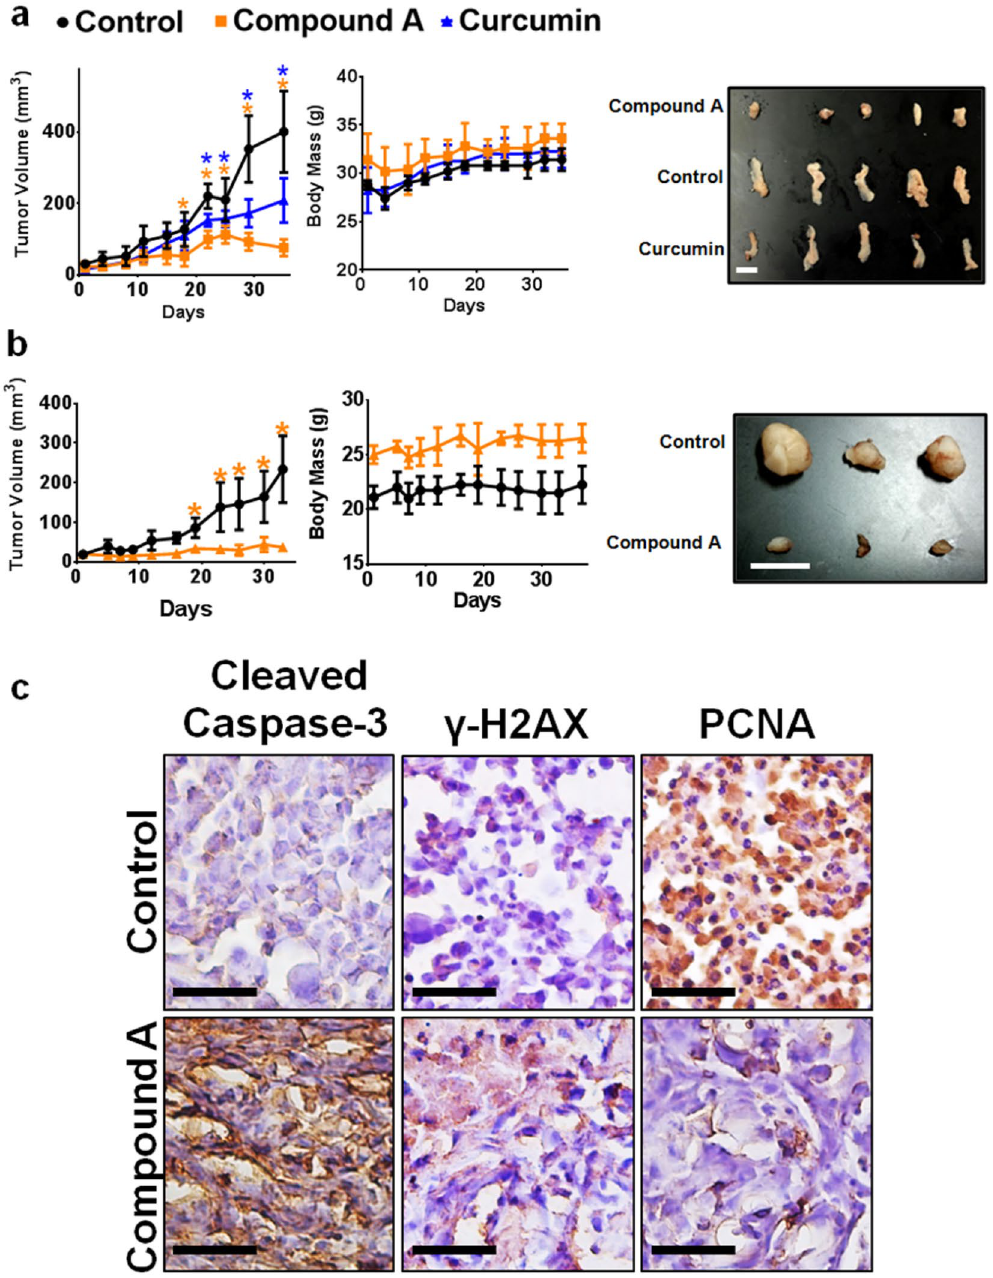
Figure 9. Intraperitoneally Administered Compound A Effectively Suppresses Triple-Negative Breast and Blood Cancer Xenograft Tumor Growth. Immunocompromised mice were subcutaneously injected with cancerous cell lines and tumors were allowed to establish. Treatments occurred every other day and the studied compound or the equivalent vehicle control administered intraperitoneally for five weeks. Tumor volume and mass were measured two times per week. ( a ) MV-4-11 xenograft study was administered with approximately 5.0 mg/kg of Compound A and 5.0 mg/kg of curcumin. Results are representative for the Control (n = 5), Compound A (n = 5), and curcumin (n = 4) treated group, each with two tumors per mouse. ( b ) MDA-MB-231 xenograft study was administered with approximately 7.5 mg/kg of Compound A. Results are representative for the Control (n = 3) and Compound A (n = 4), each with one tumor per mouse. Scale bar is 1 centimeter. ( c ) Immunohistochemistry analysis of sectioned tumor tissues from the MDA-MB-231 study. Each section was subjected to the specified antibody followed by a biotinylated secondary antibody. Detection was done using a DAB Peroxidase HRP Substrate Kit (brown) followed by Hematoxylin counterstaining (purple). Images were obtained using inverted bright field microscopy. Sectioning results are representative of three individual tumors. Scale bar is 50 microns. Statistical analysis using One-Way ANOVA. * p < 0.05 vs tumor volume of the